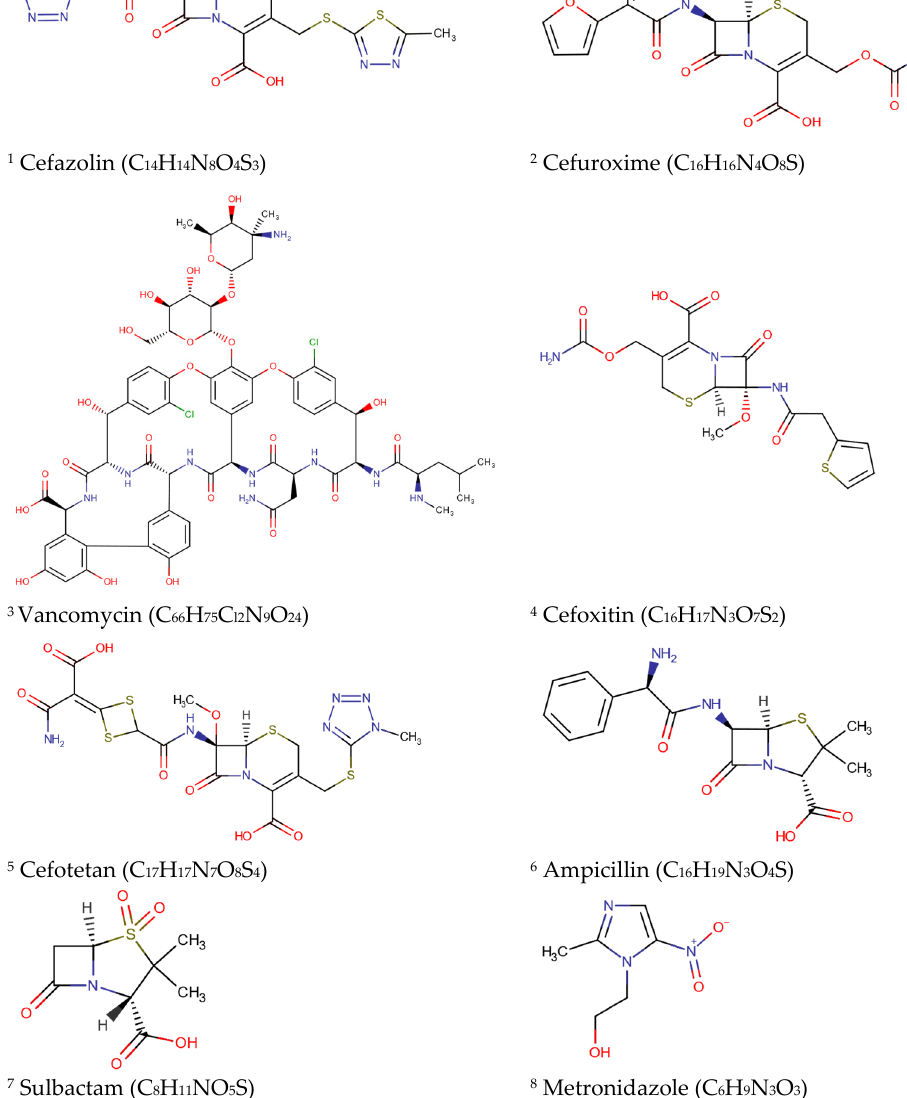
Figure 2. Chemical formulas/structures of recommended antibiotics for prophylactic prevention of SSIs (obtained from DrugBank; https://go.drugbank.com/drugs) (accessed on 9 September 2021). 4. Conventional Treatment and Management of Biofilm-Associated SSIs SSIs can be divided into three main types: superficial incisional, deep incisional, and organ/space or intracavitary. Superficial SSIs are easier to treat and usually require only simple opening and drainage, whereas deep incisional SSIs typically require more thorough surgical debridement and often adjuvant antibiotic treatment. Intracavitary SSIs also often require surgical intervention [19].